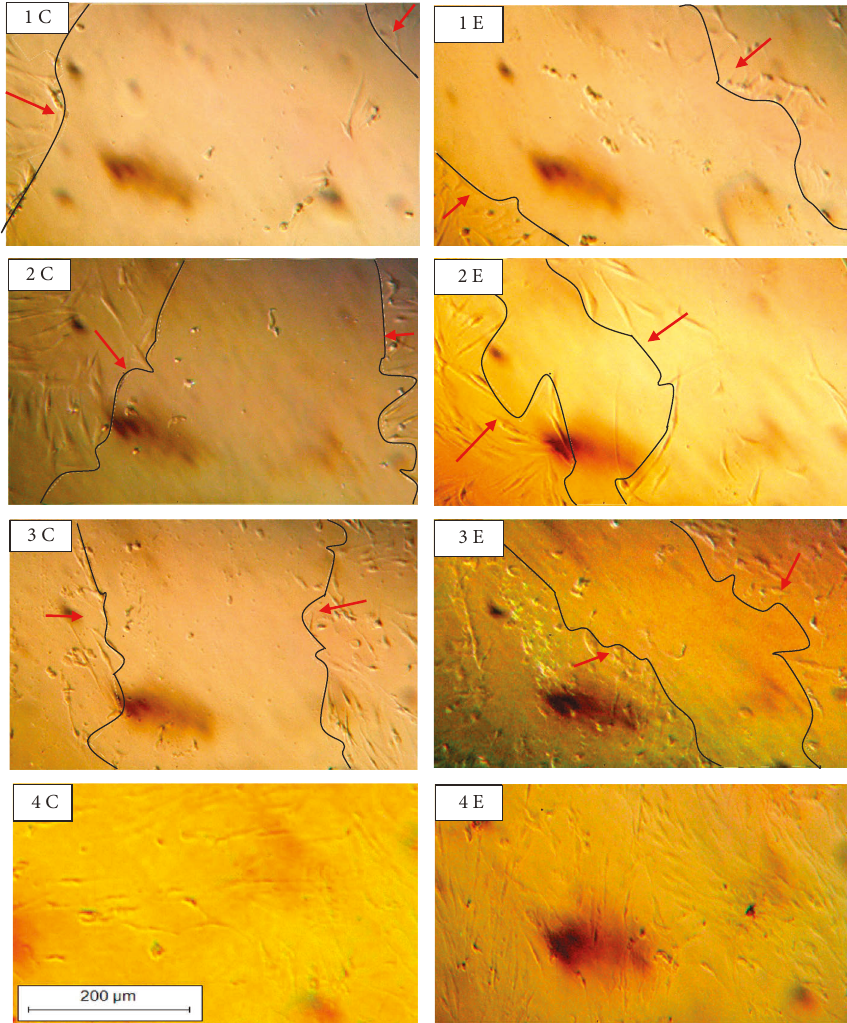
Figure 7: Microscopic images (100 × ) of scratch wound healing assay (measurement of the scratch closing area). Pictures 1, 2, 3, and 4, respectively, represent times 0, 2, 8, and 24 h after treatment. (E) is the extract group, and (C) is the control group. Red arrows and black lines represented the scratch margin. Table 4: Calculation of scratch closing area and percentage of growth at 0, 2, 8, and 24 h after treatment. Area Percent of growth Time (h) Extract Blank Extract